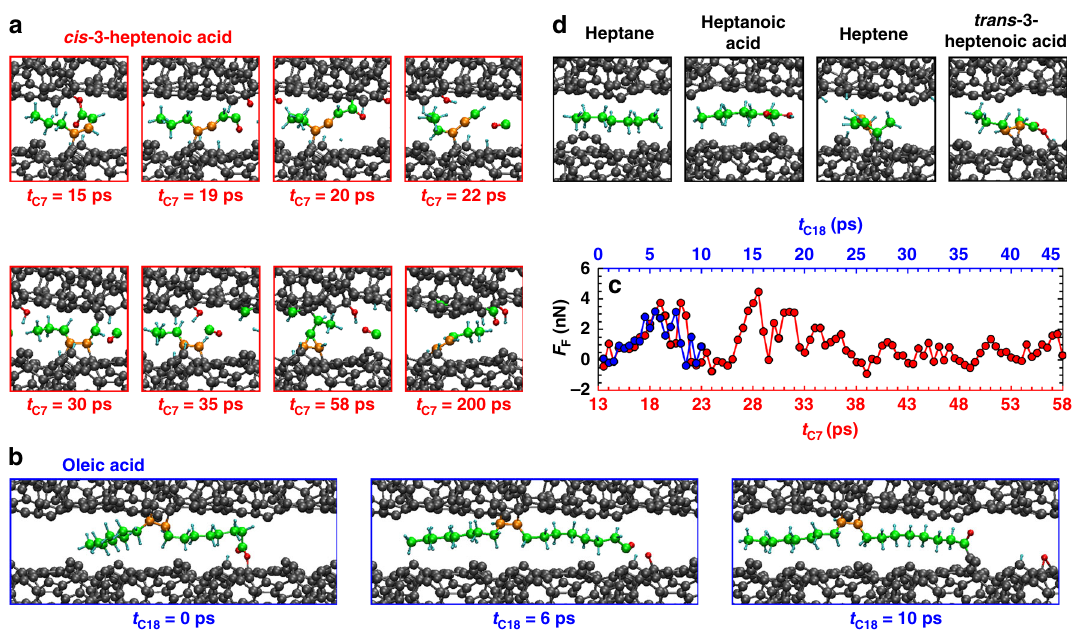
Fig. 3 QMD simulations of two ta-C surfaces (sample 1) lubricated with various organic molecules. a Snapshots (taken at the times t C7 indicated below the panels) of the cis -3-heptenoic acid trajectory. b Snapshots from a 10-ps QMD trajectory of oleic acid at time t C18 = 0, 6, and 10 ps. c Evolution of frictional forces F F for cis -3-heptenoic (red, lower horizontal axis) and oleic acid (blue, upper horizontal axis). The cis -3-heptenoic acid (panel a ) binds to both surfaces around t C7 = 13 ps, whereas the oleic acid already chemisorbs on both surfaces at t C18 = 0 ps. To highlight their similar mechanochemistry, F F is presented from t C7 = 13 ps for cis -3-heptenoic acid on the lower horizontal axis. d Final atomic con fi gurations of the other C 7 molecules at t = 0.2 ns. Green and orange spheres represent the carbon atoms that initially belong to the lubricant molecules. Orange atoms are initially double